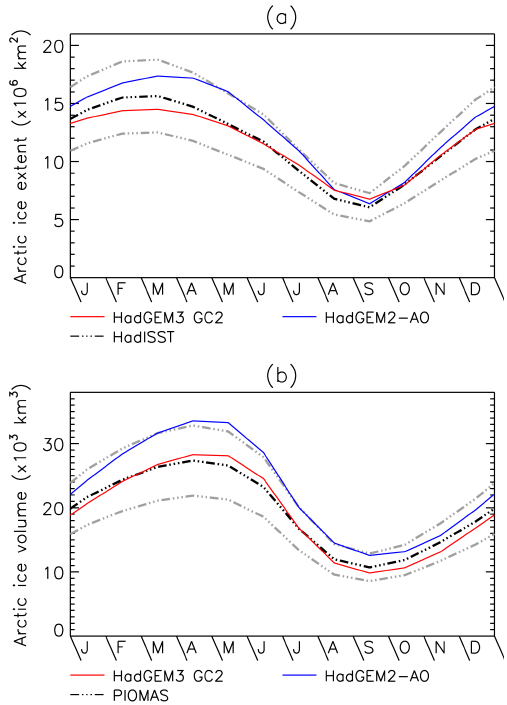
Figure 7. Annual cycle of Arctic sea-ice (a) extent, (b) volume. Colours show HadGEM3-GC2 and HadGEM2-AO CLIM experi- ment and the black line is HadISST observations (Rayner et al., 2003) (a) , PIOMAS (Pan-Arctic Ice–Ocean Modeling and Assim- ilation System) analyses (Schweiger et al., 2011) (b) . Grey lines show 20% intervals around the